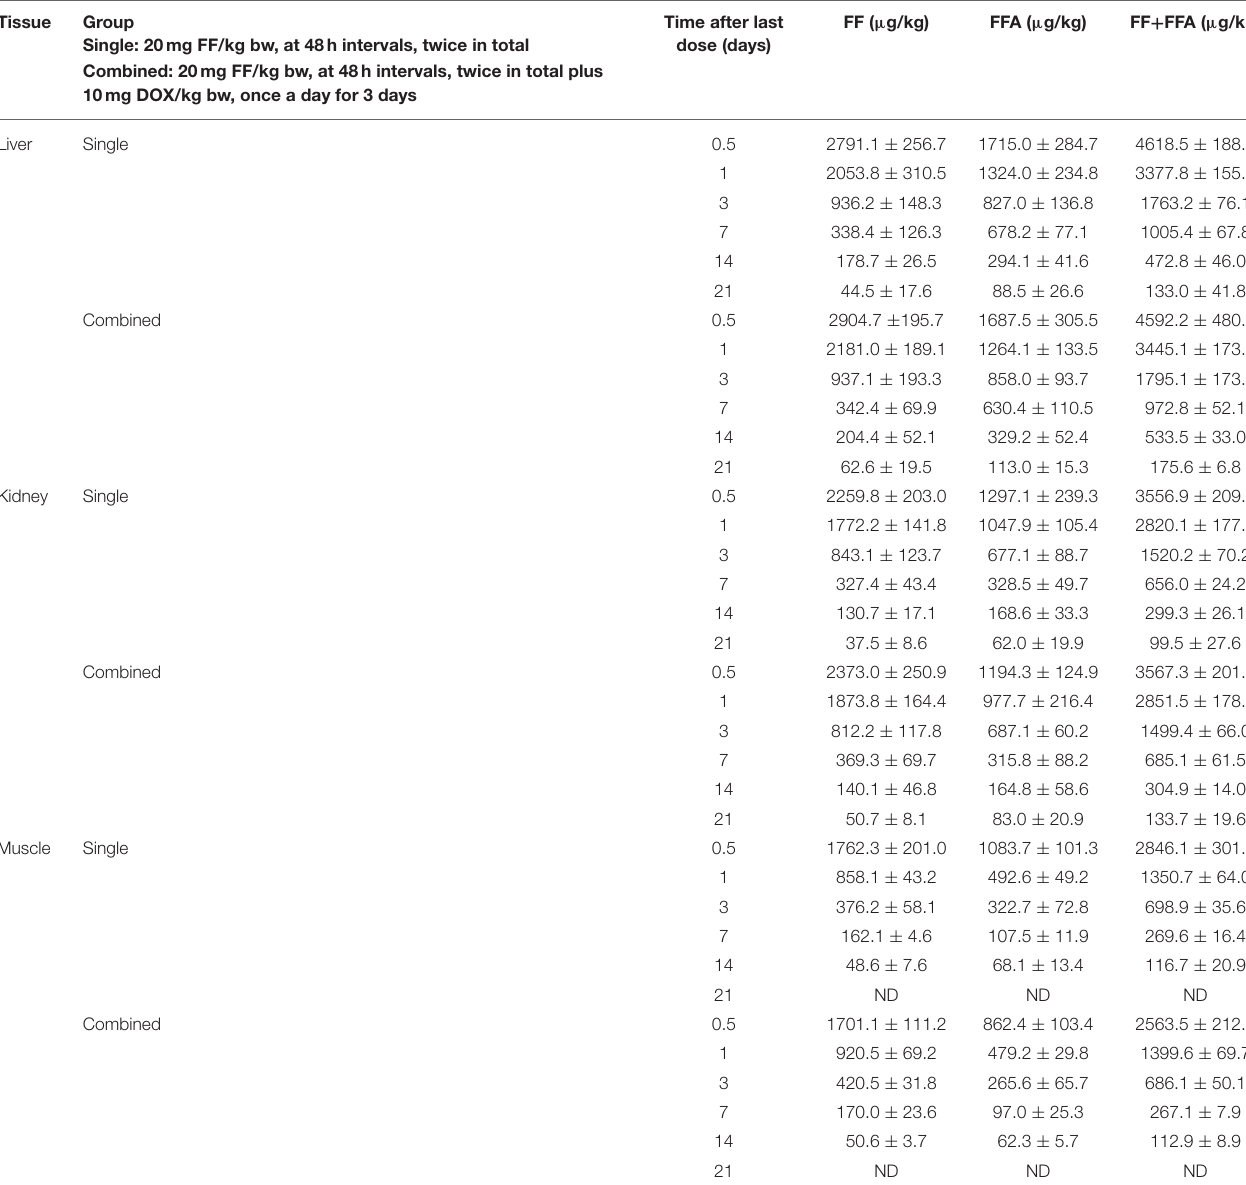
TABLE 5 | Tissue concentrations of FF and FFA for goats treated intramuscularly with FF (single group) and for goats treated with FF plus DOX (combined group). Tissue Group Single: 20mg FF/kg bw, at 48h intervals, twice in